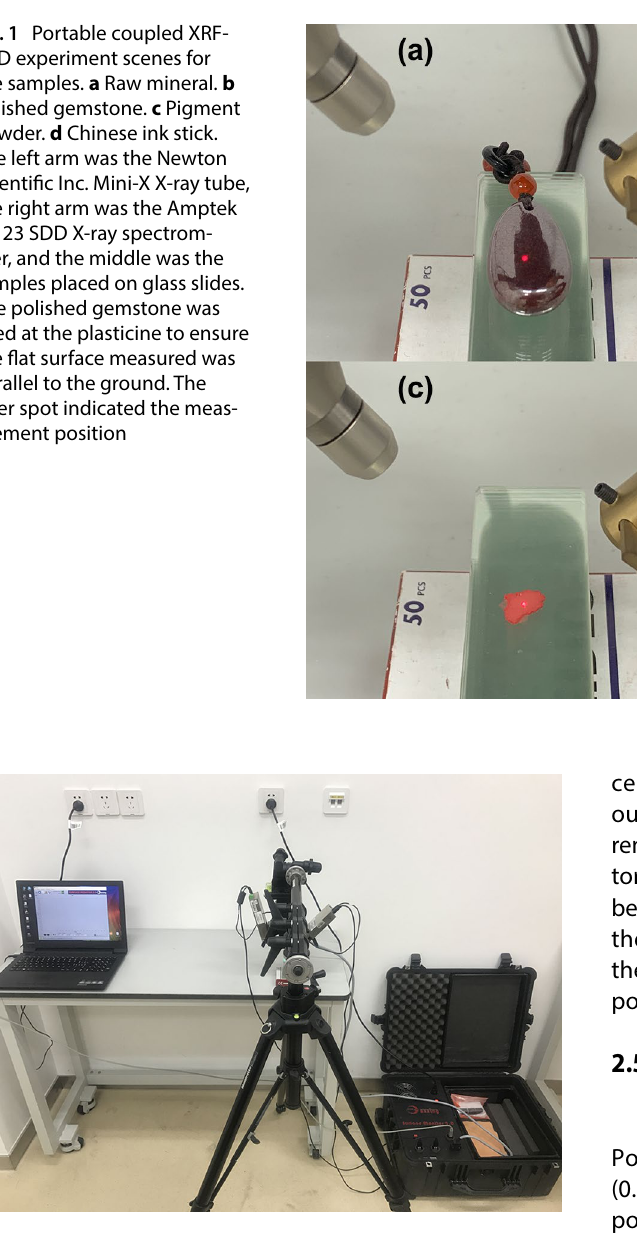
Fig. 2 The whole system including a controlling laptop (left), a removable apparatus (middle) and a multifunctional case